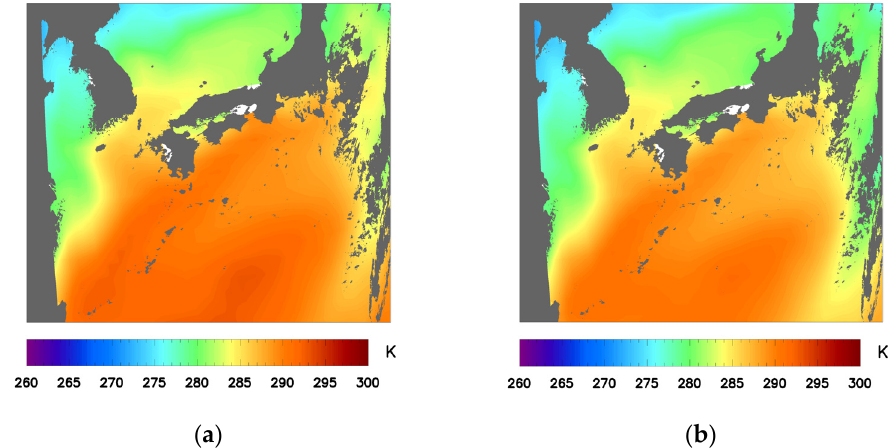
Figure 7. Simulated BT of two channels at 1:50 UTC on 28 March 2016: ( a ) 11 μ m channel; ( b ) 12 μ m channel (The gray areas are the pixels exceeding the study area, land, and obviously cloud (pixels with the BT of 11 μ m channel less than 260 K)).